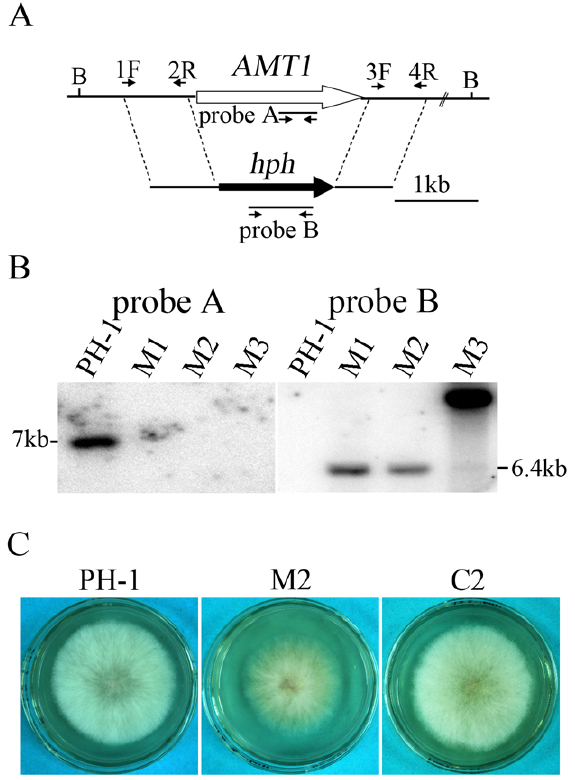
Figure 1. The AMT1 gene replacement construct and deletion mutants. A. The AMT1 locus and gene replacement construct. The AMT1 and hph genes are marked with empty and black arrows, respectively. 1F, 2R, 3F, and 4R are primers used to amplify the flanking sequences. Bam HI (B). B. Southern blot analysis with the wild type (PH- 1) and D amt1 transformants (M1, M2, and M3). All DNA samples were digested with Bam HI. The blots were hybridized with probe A (left) amplified with primers AMT1/5F and AMT1/6R and probe B (right) amplified with H852 and H850. C. Colony morphology of the PH-1, D amt1 mutant M2, and D amt1/AMT1 transformant C2 cultures grown on CM. Photographs were taken after incubation for 3 days.